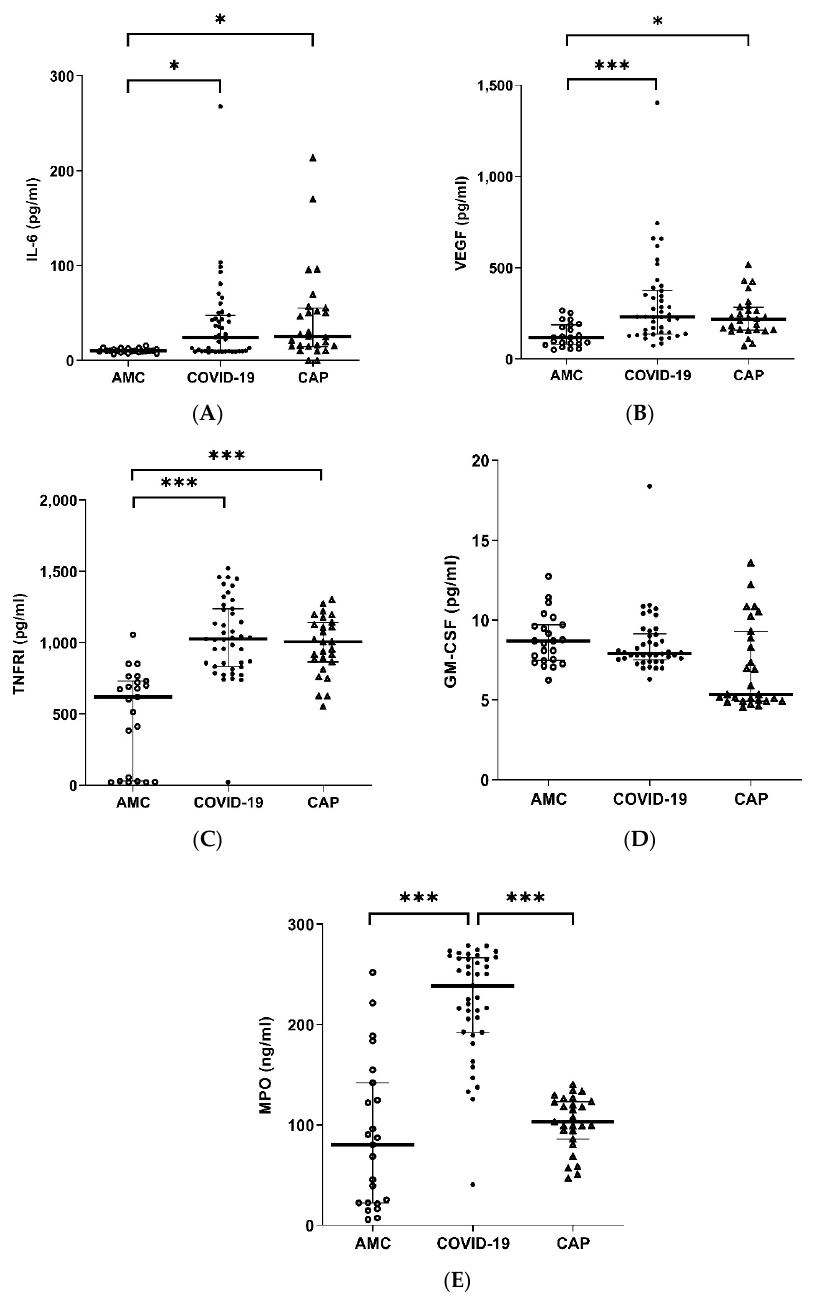
Figure 5. Plasma cytokine levels in COVID-19. Plasma cytokine concentrations in AMC (n = 23), COVID-19 (n = 41), CAP (n = 26) ( A ) IL-6 * p = 0.0296 AMC vs. COVID-19, * p = 0.0106 AMC vs. CAP. ( B ) VEGF *** p < 0.0001 AMC vs. COVID-19, * p = 0.0032 AMC vs. CAP. ( C ) sTNFRI *** p < 0.0001 AMC vs. COVID-19, *** p < 0.0001 AMC vs. CAP. ( D ) GM-CSF overall p = 0.3375, ( E ) MPO *** p < 0.0001 AMC vs. COVID-19, *** p < 0.0001 COVID-19 vs. CAP.